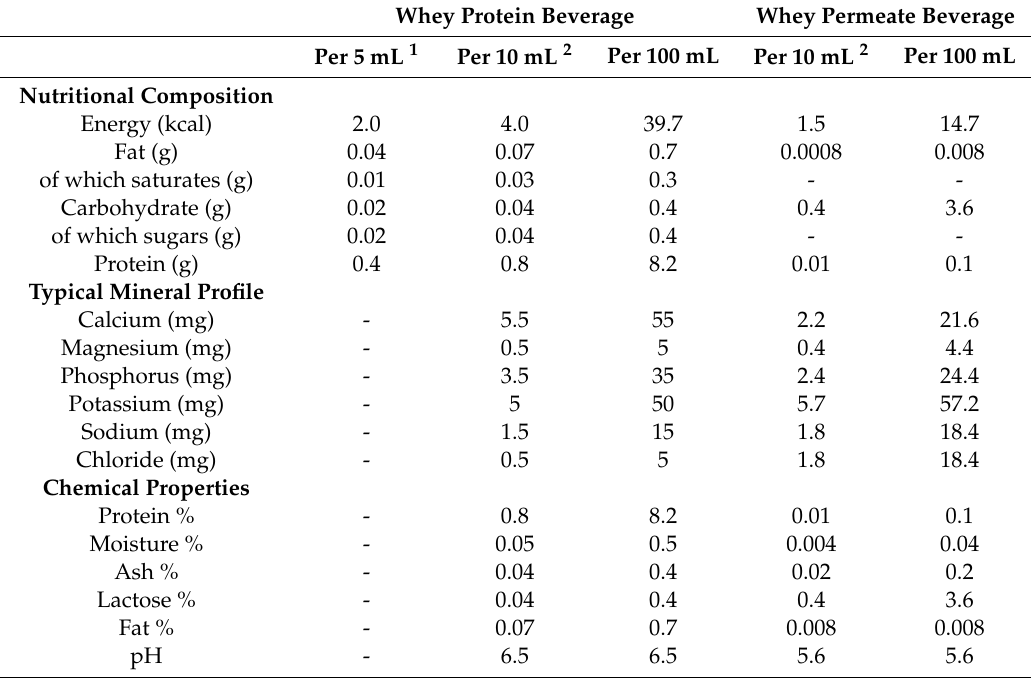
Table 2. Overview of whey protein beverage (WPB, 10% w / v ) and whey permeate beverage (WPeB, 4% w / v ).